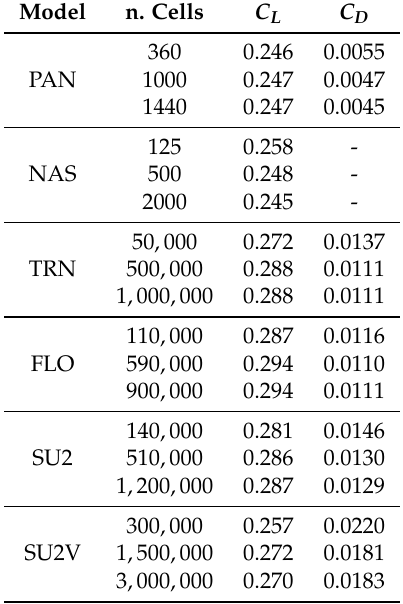
Table 3. Aerodynamic coefficients obtained on several meshes with the different numerical models for the Onera M6 wing at Mach 0.839 and angle of attack 3.06 ◦ .